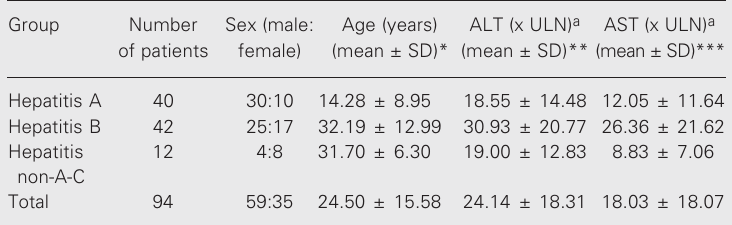
reported as multiple upper limit of normal (x ULN). The normal range for ALT is 12-50 U/l and the normal range for AST is 12-46 U/l. *Comparison of age: P < 0.001 for comparison of age between the three groups (Kruskal-Wallis test); P < 0.05 for comparison of hepatitis A vs hepatitis B group and for comparison of hepatitis A vs non-A-C (Dunn test); P = NS for comparison of hepatitis B vs non-A-C (Dunn test). **Comparison of ALT levels: P = 0.007 for comparison of ALT levels between the three groups (Kruskal-Wallis test); P < 0.05 for comparison of hepatitis A vs hepatitis B group; P = NS for comparison of hepatitis A vs non-A-C and for comparison of hepatitis B vs non-A-C (Dunn test). ***Comparison of AST levels: P < 0.001 for comparison of AST levels between the three groups (Kruskal-Wallis test); P < 0.05 for comparison of hepatitis A vs hepatitis B group; P < 0.05 for comparison of hepatitis B vs non-A-C (Dunn test); P = NS for comparison of hepatitis A vs non-A-C (Dunn